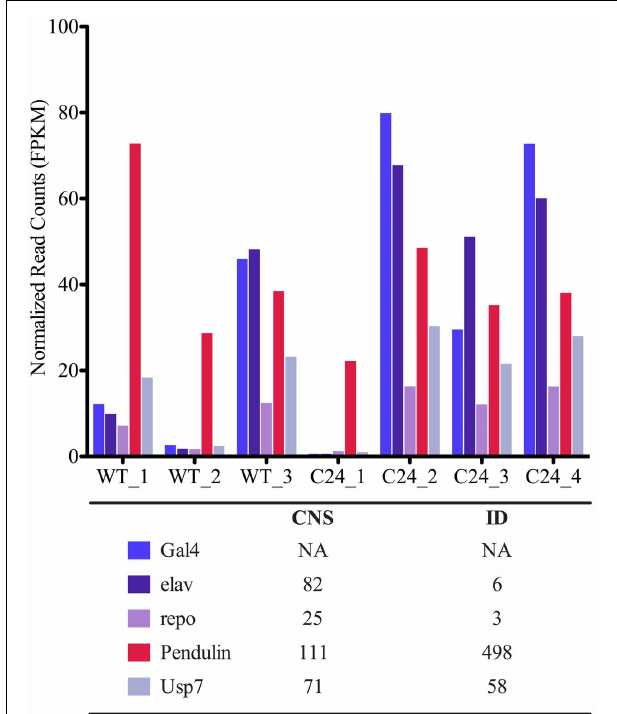
FIGURE 2 | Assessment of tissue specificity of mRNA-seq libraries using markers genes. Expression levels of selected marker genes in pilot mRNA-seq libraries using normalized expression counts for gene length (FPKM) (see Materials and Methods). Plot legend presents mRNA-seq FPKM estimates for endogenous genes in L3 stage larvae central nervous system (CNS) and Imaginal Discs (ID) reported by Marygold et al. (2013).